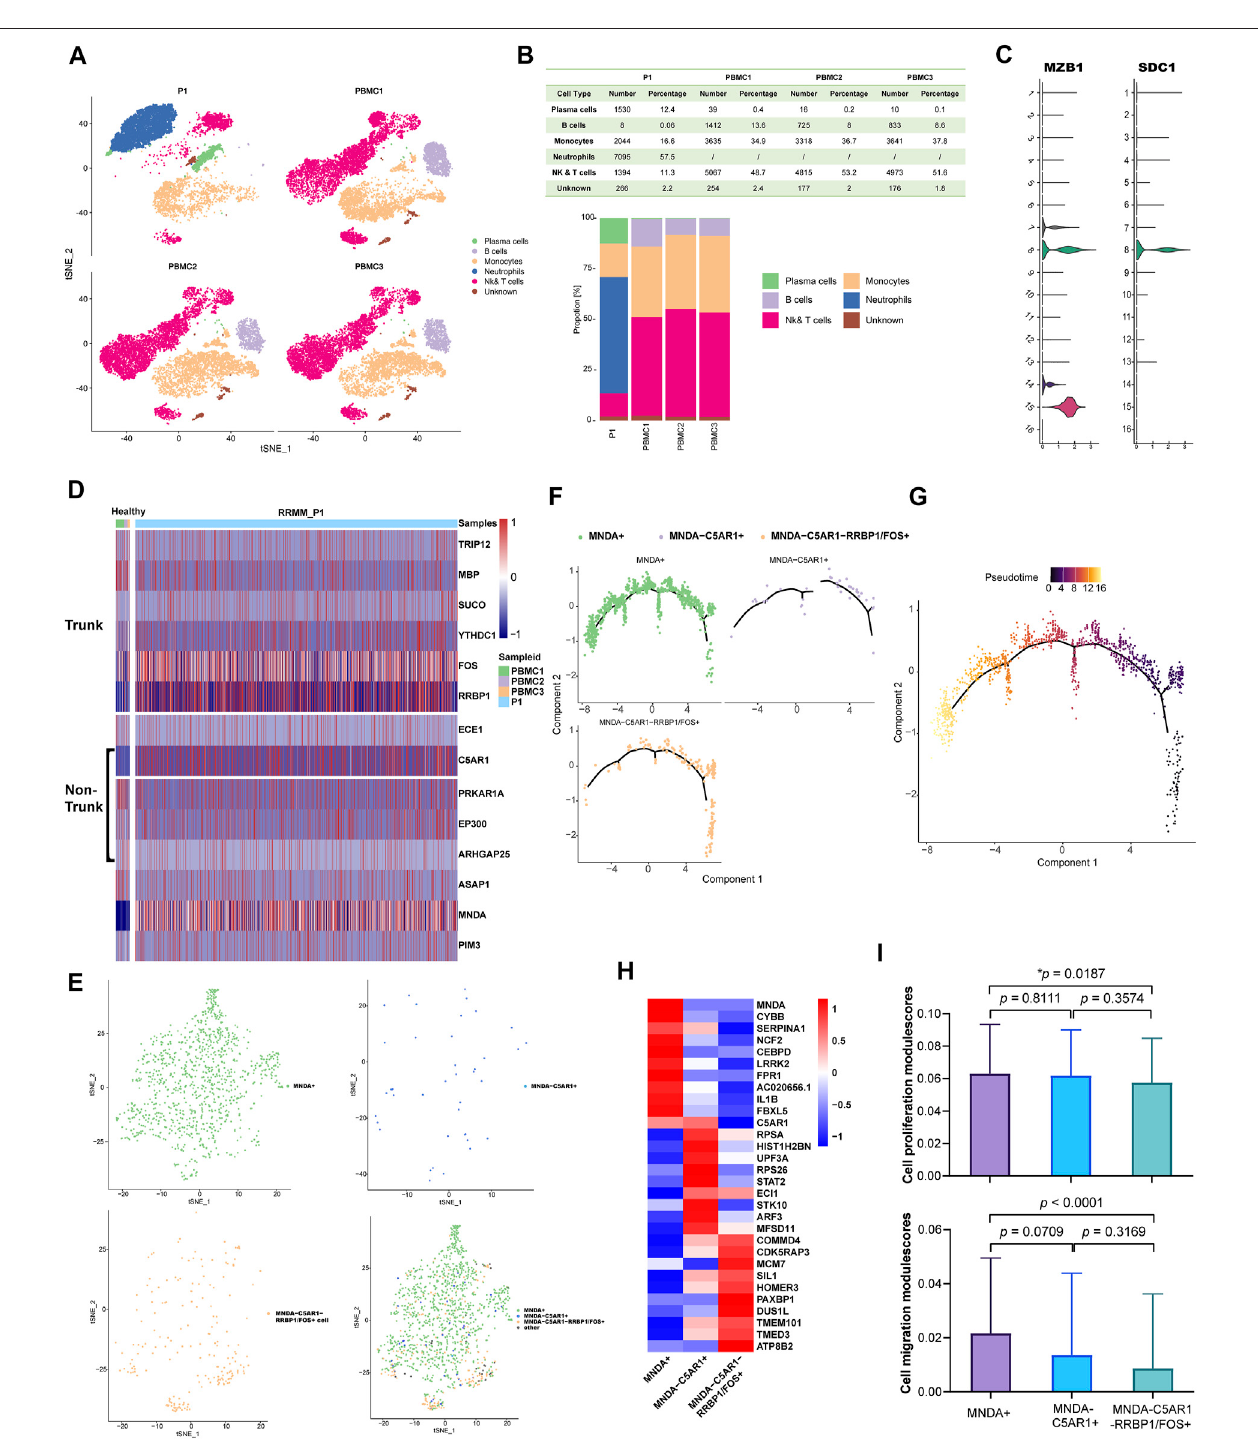
FIGURE2|(A) ComparingwiththedataofthreehealthyPBMCcontrolsfromthe10 × platformdatabasedescribedabove,celltypeswereidenti fi edinP1_PD9and were visualized by t-SNE (16 clusters in total). (B) Stacked bar plots show that compared with normal specimens, plasma cells signi fi cantly increased and B cells signi fi cantly decreased in the P1 sample. (C) According to gene markers, including SDC1 (CD138) and MZB1, cluster 8 was fi nally determined to be the malignant PCs. (D) AccordingtotheWESresultsofevolutionarytreefromP1in Figure1B andthemutationalpro fi lingoftrunkandnon-trunk,themRNAexpressionlevelsofthese mutant genes between PCs from normal control (PBMC1, 2, 3) and malignant PCs from P1 were compared and showed in the heatmap. (E) Malignant PCs in P1 was furthergroupedasthreesub-clusters:1)PCsexpressedhigherlevelofMNDA(MNDA+,thegreennon-trunksub-groupinWESresults);2)PCsexpressedhigherlevelof